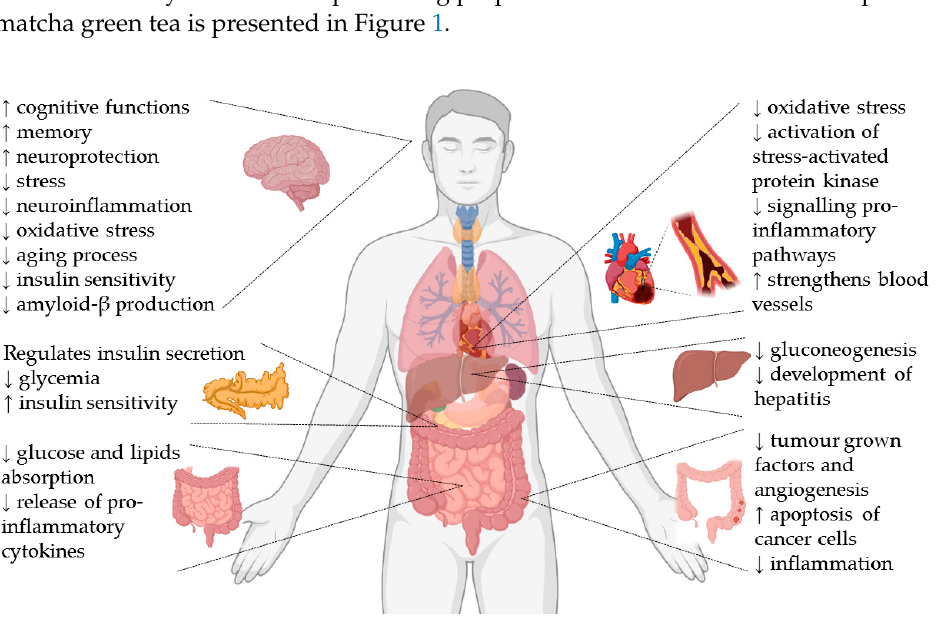
Figure 1. Health-promoting properties of the main bioactive compounds of matcha green